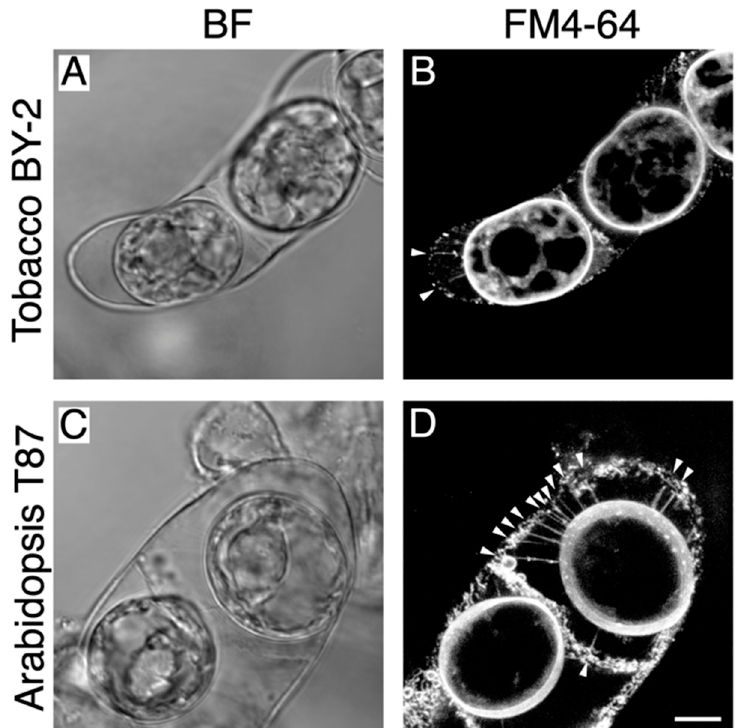
Figure 1. Hechtian strands in tobacco BY-2 and Arabidopsis T87 cells. Plasmolyzed tobacco BY-2 cells ( A , B ) and Arabidopsis T87 cells ( C , D ) were stained with 10 µ M FM4-64 to visualize the plasma membrane and Hechtian strands ( B , D ). White arrowheads in ( B , D ) indicate Hechtian strands. BF, bright field images. Scale bar = 10 µm.